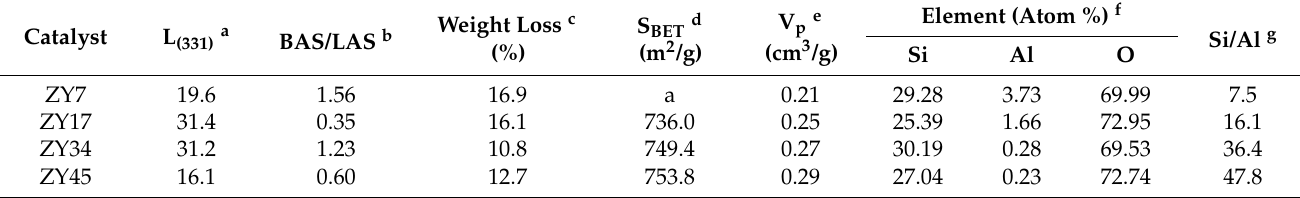
Table 1. Physicochemical properties and composition of the Y-type zeolites.